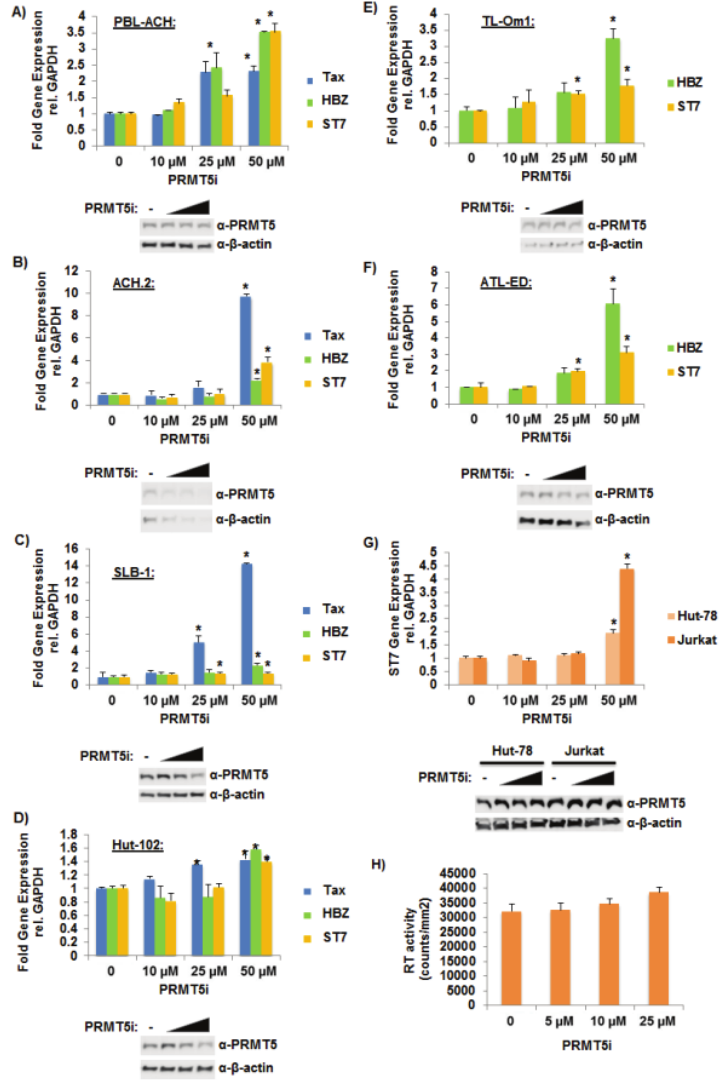
Figure 4. Selective inhibition of PRMT5 enhanced HTLV-1 gene expression. ( A ) PBL-ACH, ( B ) ACH.2, ( C ) SLB-1, ( D ) Hut-102, ( E ) TL-Om1, ( F ) ATL-ED, ( G ) Jurkat, and Hut-78 cells were treated with titrating amounts of PRMT5i for 48 h. (PBL-ACH, ACH.2, SLB-1, and Hut-102 cells are HTLV-1-tranformed lines; TL-Om1 and ATL-ED are ATL-derived Tax-negative lines; Jurkat and Hut-78 are HTLV-1 negative lines.) Cells were collected by slow centrifugation at 800 x g for 5 min. Quantitative RT-PCR for Tax (where indicated), HBZ (where indicated), ST7, and GAPDH was performed on mRNA isolated from cells in each condition. Transcript level was determined using the ∆∆ Ct method and normalized to relative GAPDH levels. Data are presented in histogram form with means and standard deviations from duplicate experiments; vehicle-treated cells were set to 1 (upper panel). Student’s t test was performed to determine significant differences in viral transcript levels between vehicle and inhibitor treated cells; p < 0.05 (*). Inhibitor-treated cells were also subjected to immunoblot analysis to compare the levels of endogenous PRMT5 expression. β -actin expression was used as a loading control (lower panel); ( H ) ACH-2 cells were treated with titrating amounts of PRMT5i for 48 h. Average reverse transcriptase (RT) activity of triplicate experiments is